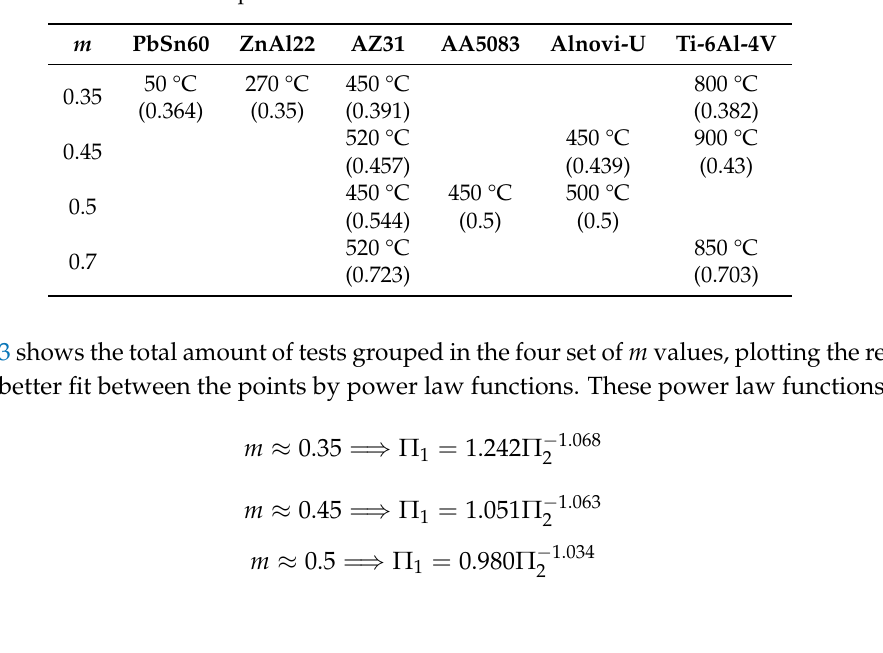
Table 2. Sets of parameter m with materials and their test